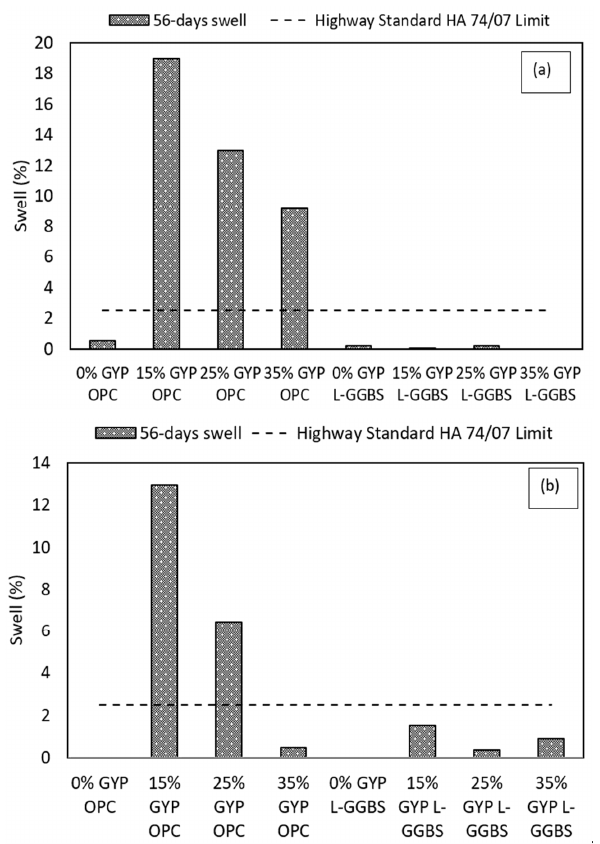
Figure 6. Vertical swell of OPC and L-GGBS-treated gypseous soils. ( a ) 7-days cured. ( b ) 28-days cured. Table 5. Swell severity classification.